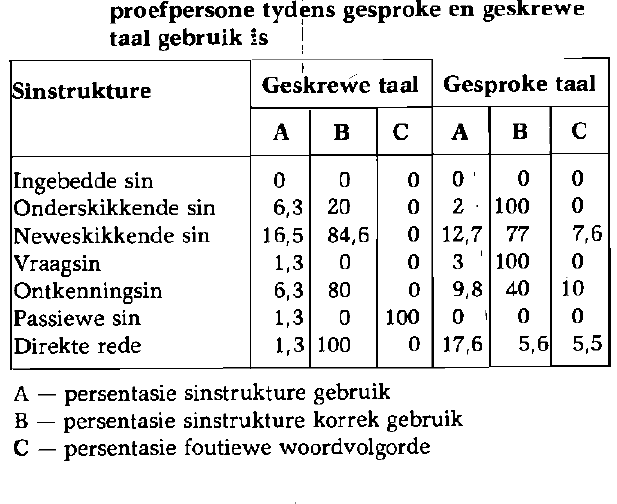
Die gegewens in verband met die tipe sinstrukture wat deur die proefpersone tydens die gesproke en geskrewe taal ge- bruik is, word in Tabelle 2, 3 en 4 weergegee. Tabel 2 verskaf 'n uiteensetting van die geevalueerde sin- strukture wat deur die proefpersone tydens gesproke en geskrewe taal gebruik is. In Tabel 3 word opsommende inlig- ting'aangaande die geevalueerde sinstrukture vervat. Tabel 4 / dui die voorkoms van persentasie foutiewe sinsvorme tydens gesproke en geskrewe taal aan. Tabel 2: Geevalueerde sinstrukture wat deur die proefpersone tydens gesproke en geskrewe taal gebruik is j Sinstrukture